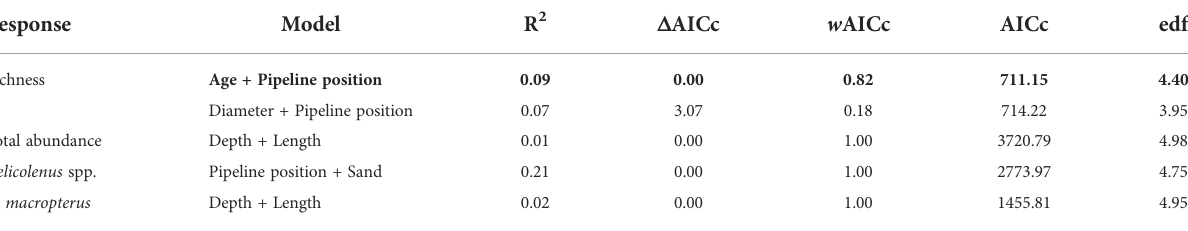
TABLE 8 Generalised additive models (GAMs) for predicting total fi shery target species abundance, fi shery target species richness, and the total abundance of Helicolenus spp. and Nemadactylus macropterus on pipelines in depths < 400 m in the south-east, within 2 Akaike information criterion of the top